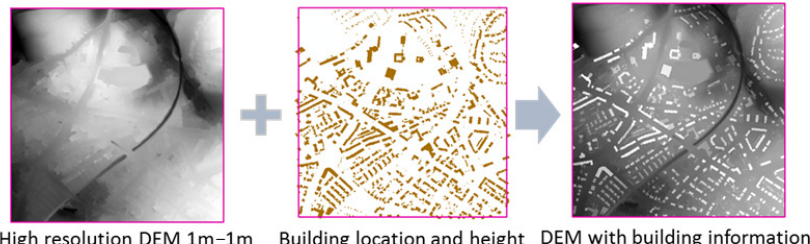
Figure 4. Processing of high-resolution digital elevation model with building information.